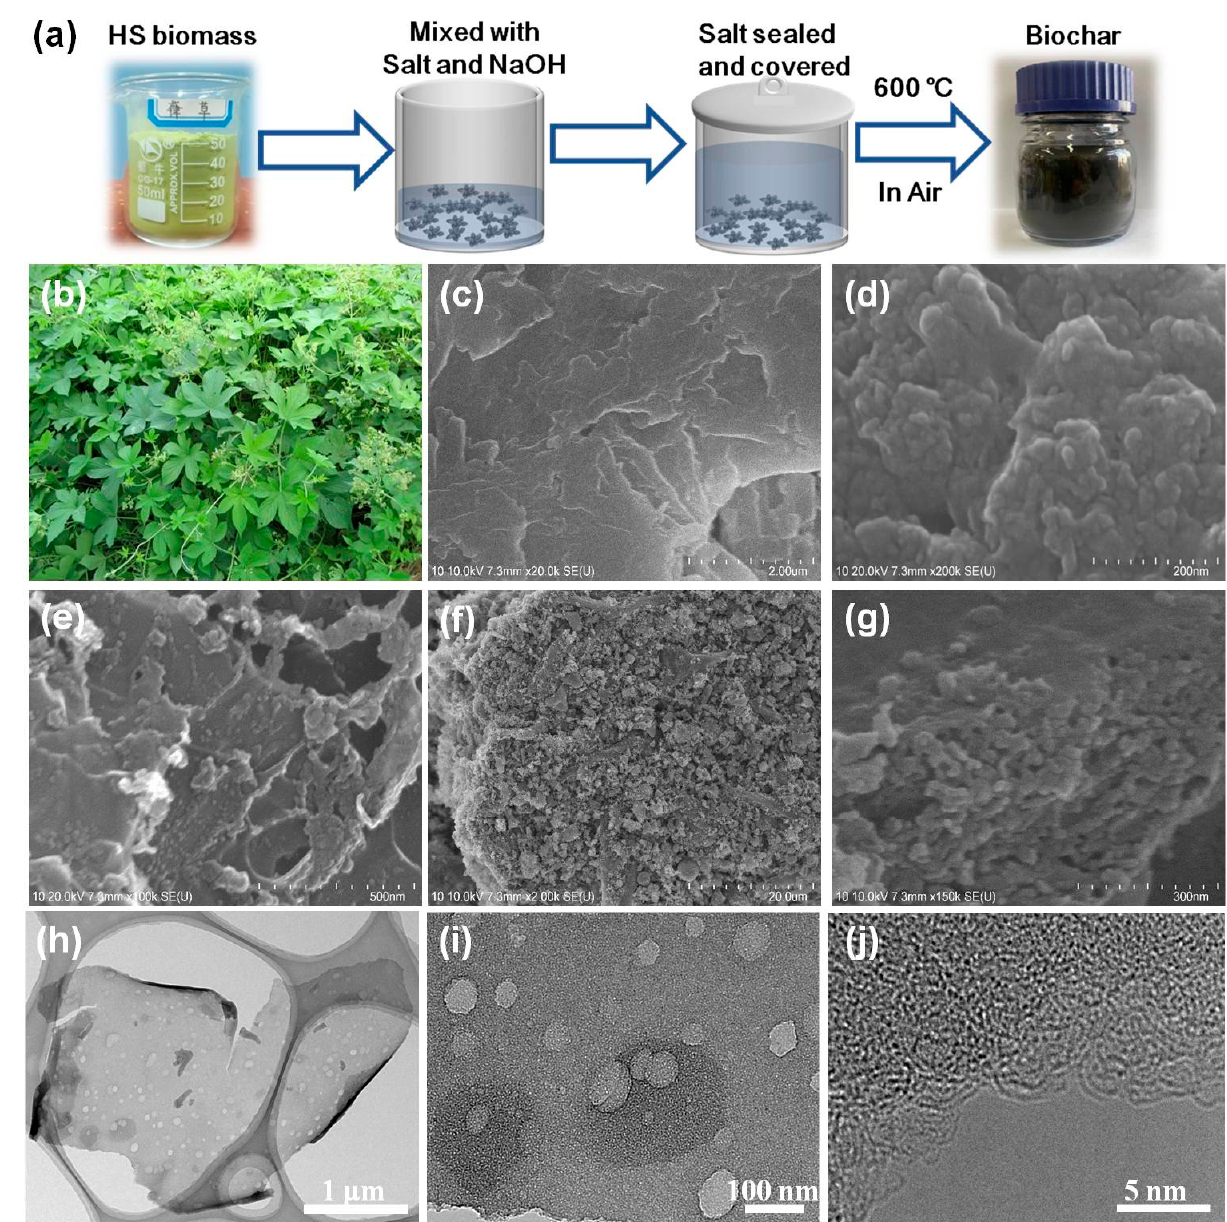
Figure 2. ( a ) Illustration of the preparation process of the biochar, ( b ) HS plant growth in the north of China, the inset is the corresponding ground powders. FE-SEM image of ( c ) the pristine HS biomass, ( d ) HSC-N 2 , ( e ) HSC-M, and ( f , g ) HSC-MA-2 with different magnifications. ( h , i ) TEM images with different magnifications and the ( j ) HRTEM image.